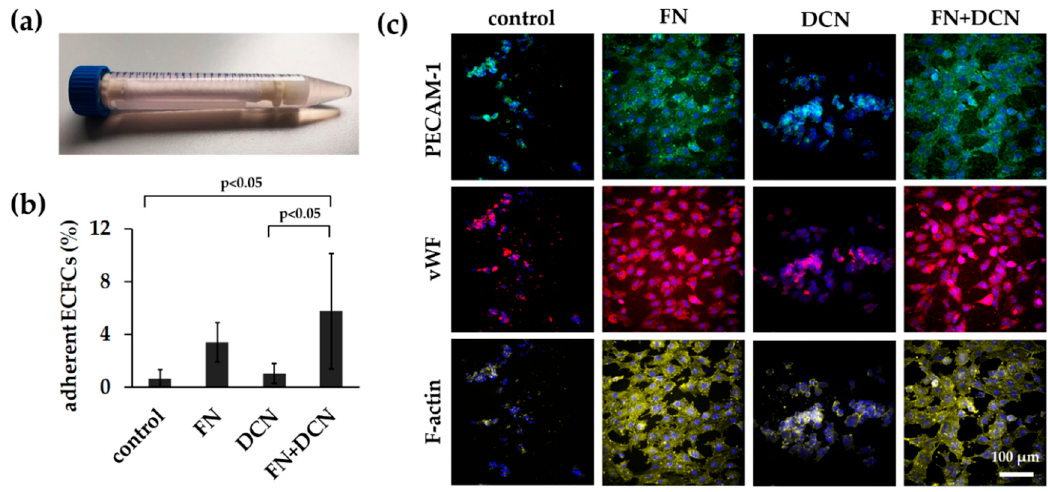
Figure 6. In vitro simulation of in vivo processes: ECFC attraction under dynamic conditions. ( a ) ECFCs were seeded into tubular constructs and cultured for 24 h on a roller mixer. ( b ) Adherent cells after 24 h on control scaffolds and on DCN-, FN-, and FN + DCN-coated scaffolds. FN + DCN coating shows a significantly higher cell number when compared with DCN coating and controls. One-way ANOVA, n = 4. ( c ) PECAM-1 (green), vWF (red), and F-actin (yellow) expression in ECFCs. Cells on FN and FN + DCN show a more spread morphology in contrast to the DCN and control samples.